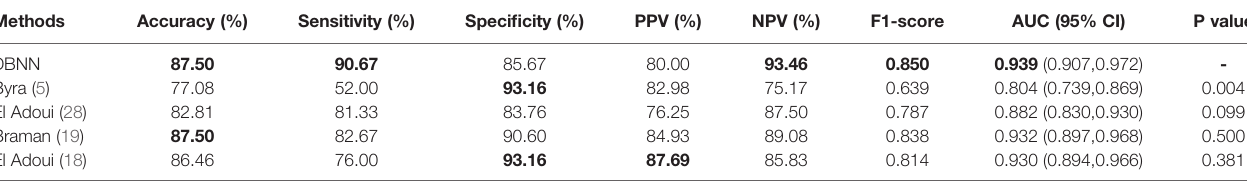
Values in bold black font represent the best performance in each column.